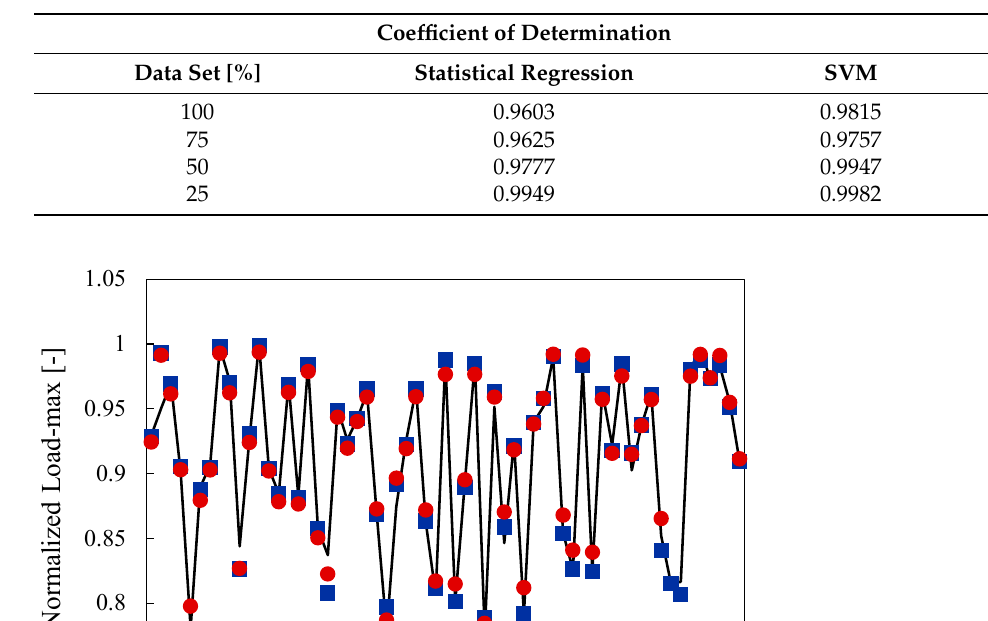
Table 5. Prediction accuracy of Load-max for SVM and statistical regression data with the number of data.